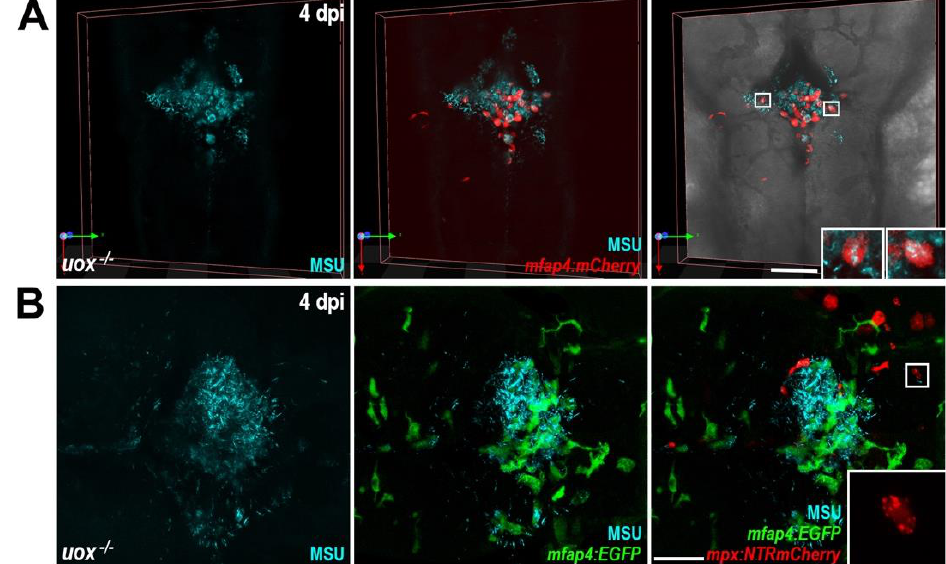
Figure 6. MSU crystal aggregates within uricase-deficient larvae are dominated by macrophages. ( A ) Live confocal imaging of MSU crystals within Tg(mfap4:mCherry);uox -/- larvae at 4 days post injection (dpi). Insets, magnified views of boxed regions showing MSU crystal-laden macrophages. ( B ) Live confocal imaging of MSU crystals within Tg(mfap4:EGFP);(mpx:NTRmCherry);uox -/- larvae at 4 dpi. Inset, magnified view of boxed region showing red fluorescent neutrophil debris. Scale bars: 100 µm in ( A ), 50 µm in ( B ).